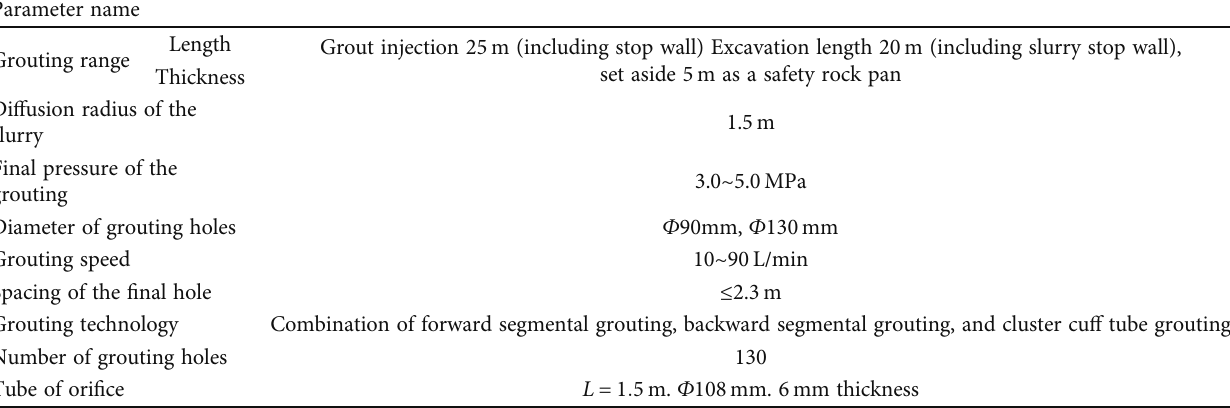
Table 4: Grouting